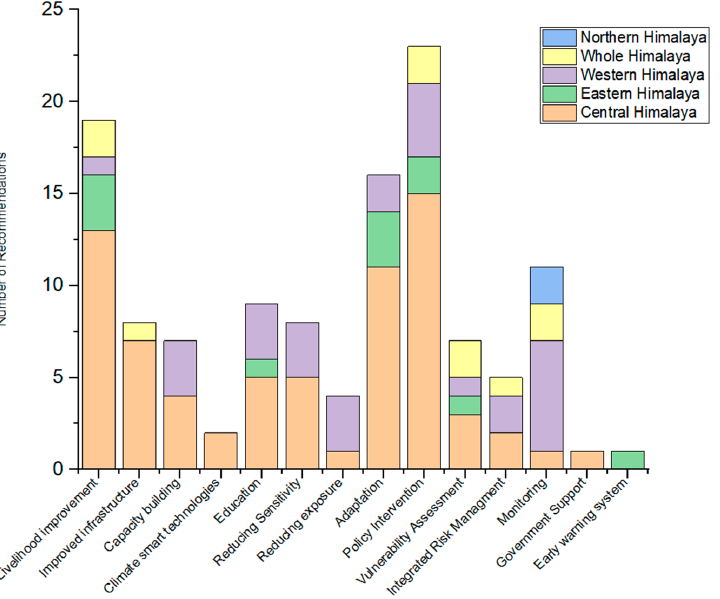
Figure 6. The recommendations for vulnerability mitigation for the different regions in the Himala- yas.